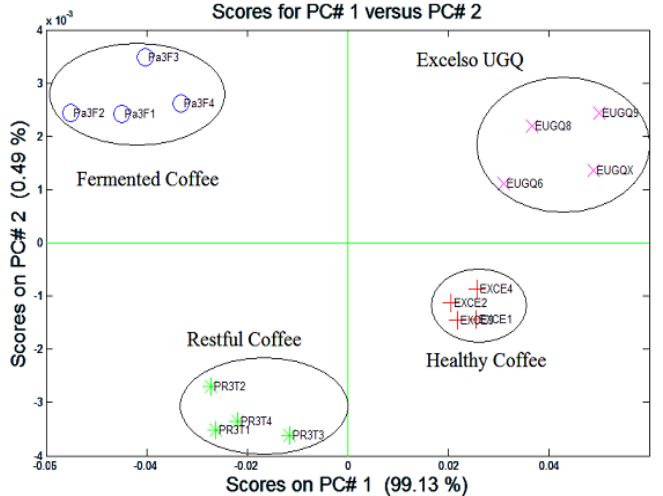
Figure 7. PCA graph with different types of cluster (coffee with defects and without